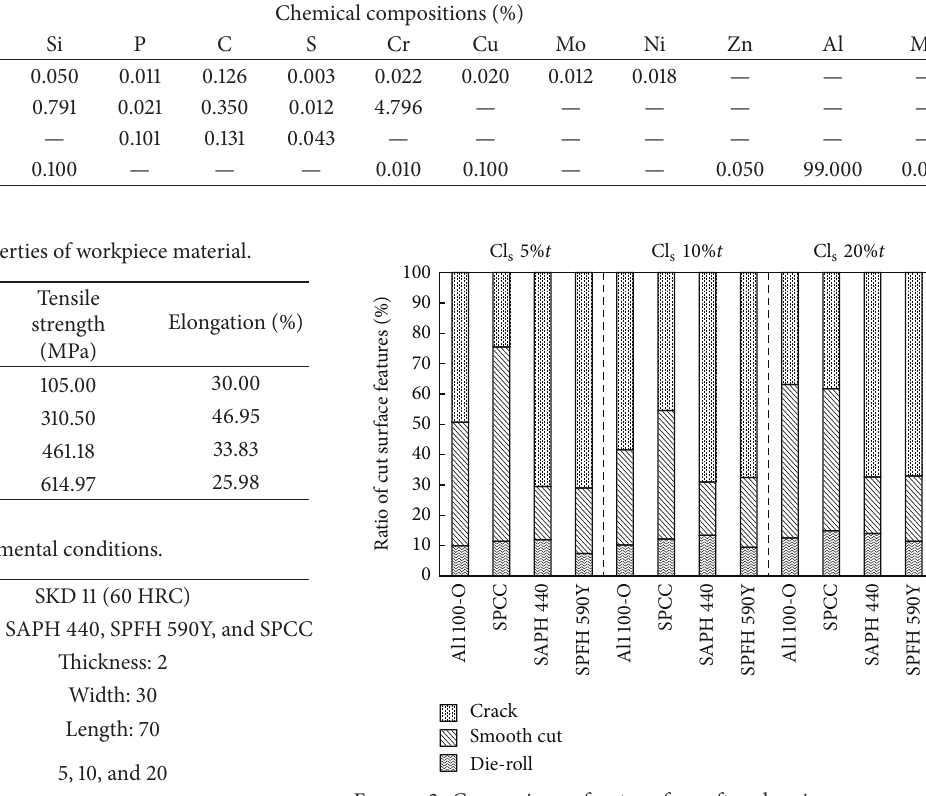
Figure 2: Comparison of cut surface after shearing process with respect to the shearing